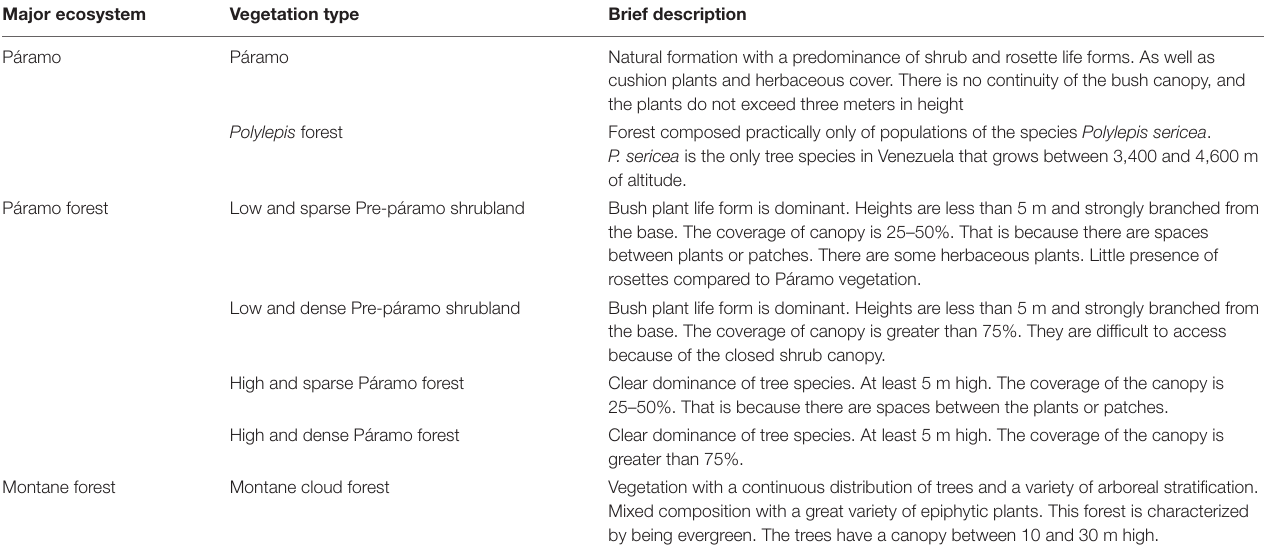
TABLE 3 | Description of vegetation types for the Sierra Nevada National Park area, based on the vegetation maps for 1952 and 1998, Cordillera de Mérida, Venezuela. Major ecosystem